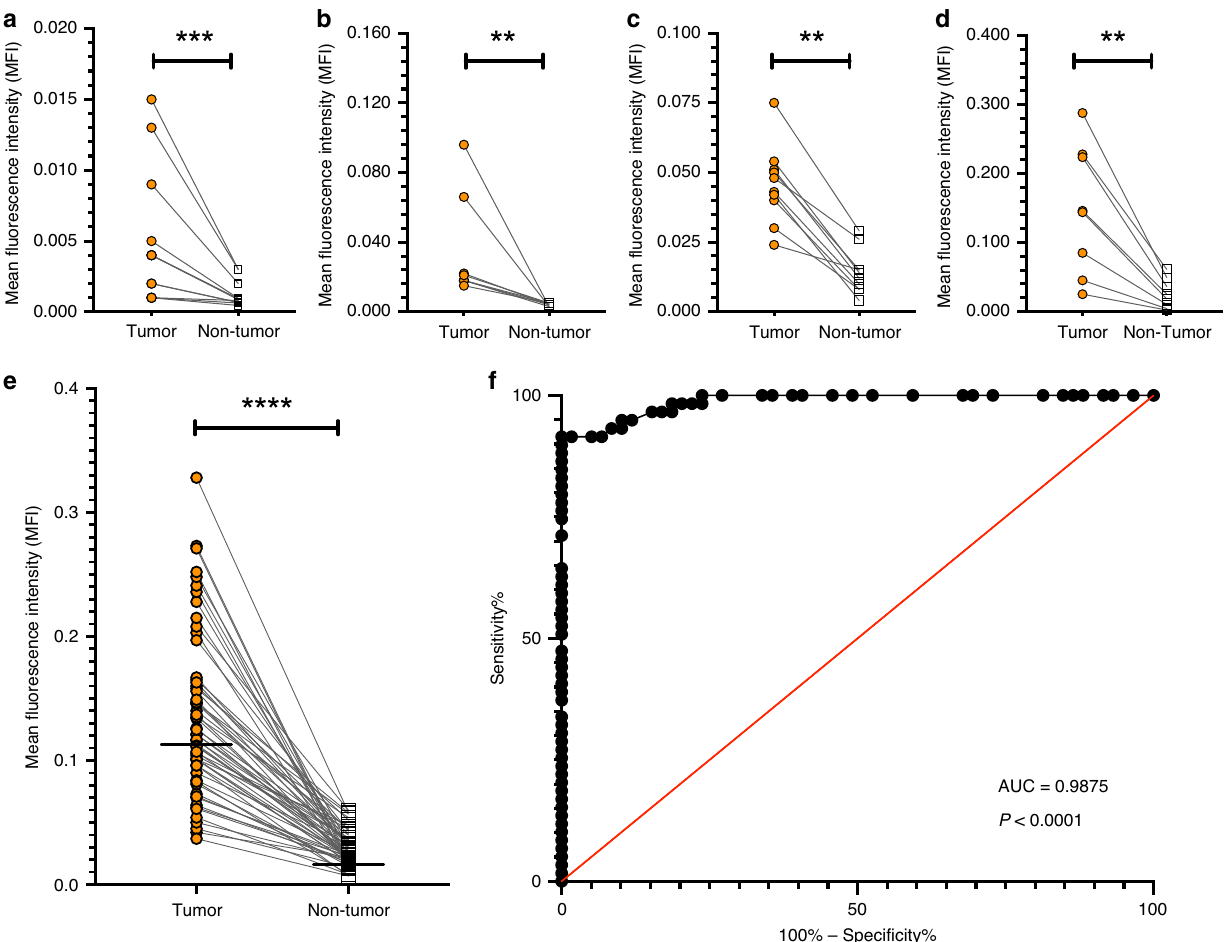
Fig. 5 Dose-independent mean fl uorescence intensity separation between tumor tissue and non-tumor tissue. Tumor and non-tumor tissue mean fl uorescence intensities (MFI) from the 0.1 mg per kg cohort, P = 0.0005 ( a ); 0.3 mg per kg cohort, P = 0.0078 ( b ); 0.5 mg per kg cohort, P = 0.0020 ( c ); 0.8 mg per kg cohort, P = 0.0078 ( d ); and 1.2 mg per kg cohort, P < 0.0001, Wilcoxon test, two-sided ( e ). The dots represent the MFI of single tissue slices. The receiver-operator characteristics curve is based on the calculated MFI of the tumor and normal tissues from the 1.2 mg per kg dose cohort, P < 0.0001; area under the curve 0.9875, n = 59, with a con fi dence interval of 95% using Wilson/Brown method ( f ). ROC receiver operators curve, AUC area under the curve. ** P ≤ 0.01; *** P ≤ 0.001; **** P ≤ 0.0001. Source data are provided as a Source data fi